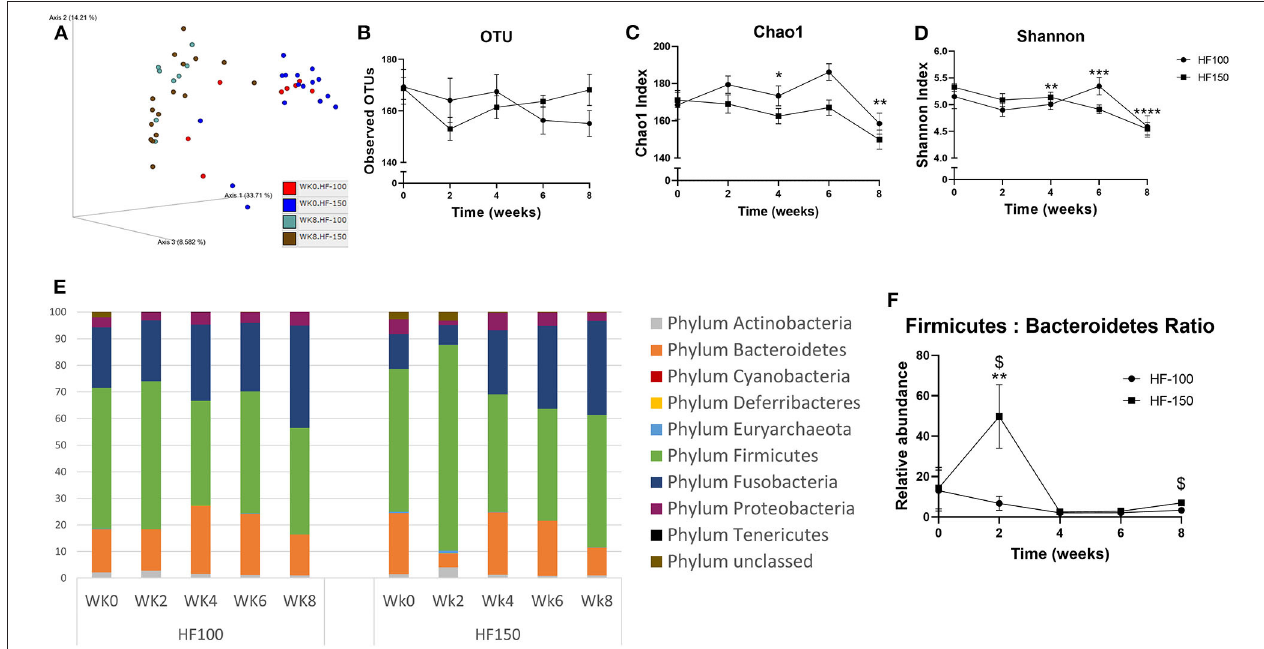
FIGURE 3 | (A) The β -diversity, the indices of (B) OTUs, (C) Chao1 and (D) Shannon, (E) relative abundance of bacterial on phyla level and (F) Firmicutes/Bacteroidetes ratio found in fecal samples of dogs fed the high-fat diet at maintenance (HF-100; n = 8) and at 150% maintenance (HF-150; n = 16) for 8 weeks. Data are mean ± SEM. * P < 0.05, ** P < 0.01, *** P < 0.001, **** P < 0.0001 during the HF-150 diet vs. week 0 , $ P < 0.05 HF-150 vs. HF-100 at weeks 2 and 8.